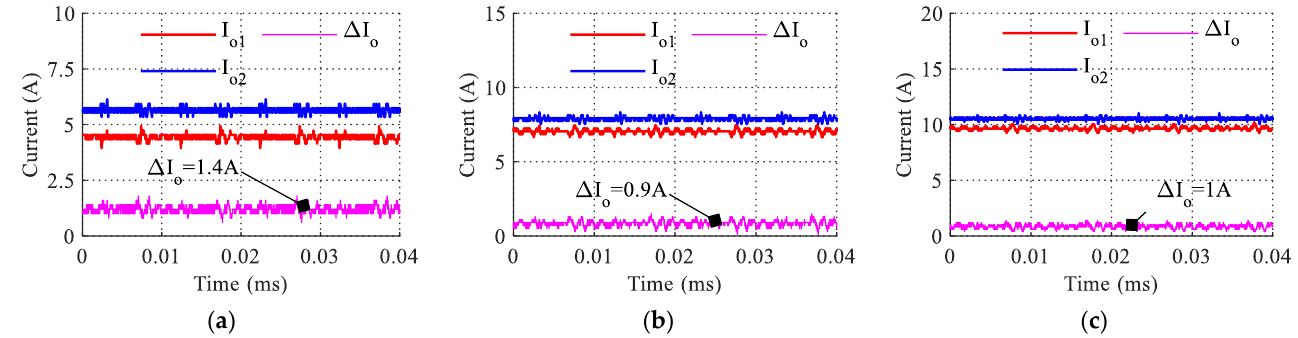
Figure 23. Experimental result of output current after only using calculation compensation: ( a )